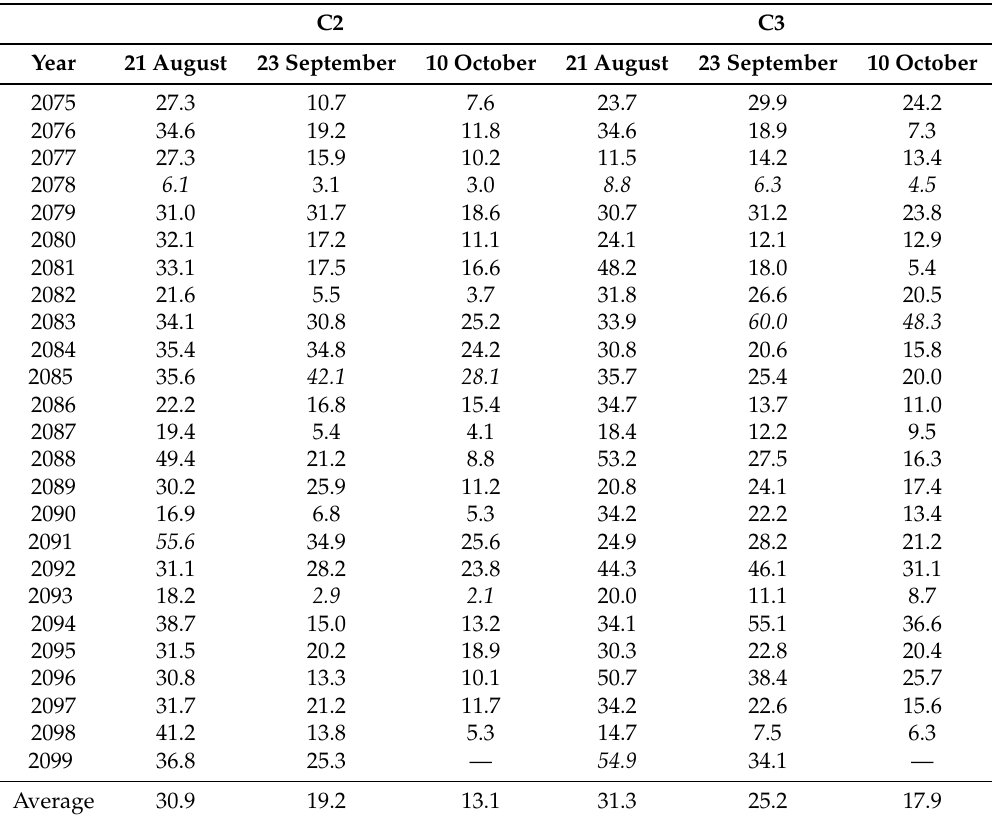
Table 2. Future time yields in tha − 1 for C2 and C3 SST-ensemble and for early, mid, and late planting dates. C2 C3